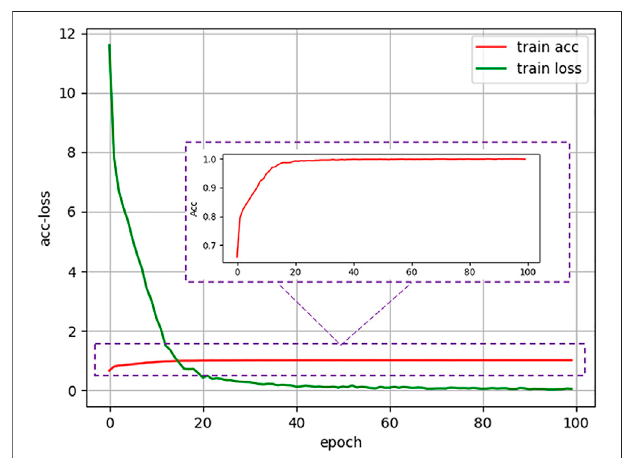
FIGURE3 | Accuracy and loss curve ofantiinterference cataract arti fi cial intelligence diagnosis model in the training